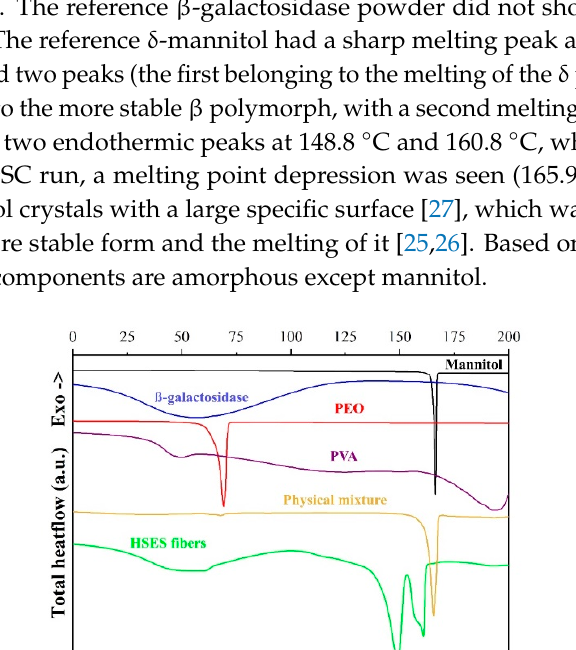
Figure 5. X-ray powder diffraction (XRPD) patterns of β -galactosidase; polyvinyl alcohol (PVA); polyethylene oxide (PEO); δ -mannitol; α , β -mannitol; the physical mixture of PVA, PEO, α , β - mannitol, and β -galactosidase; and the ground electrospun PVA + PEO + mannitol + β -galactosidase. To evaluate the molecular interactions, FTIR spectroscopy was applied on the samples (Figure 6). PVA and mannitol molecules contain free hydroxyl groups (which can act as potential proton donors for hydrogen bonding) and β -galactosidase possesses numerous different groups that can act as potential proton donors or receptors. Therefore, hydrogen bonding might occur in the fibers. Characteristic absorption peaks of β -galactosidase are at 3298 cm − 1 due to OH stretching and at 2939